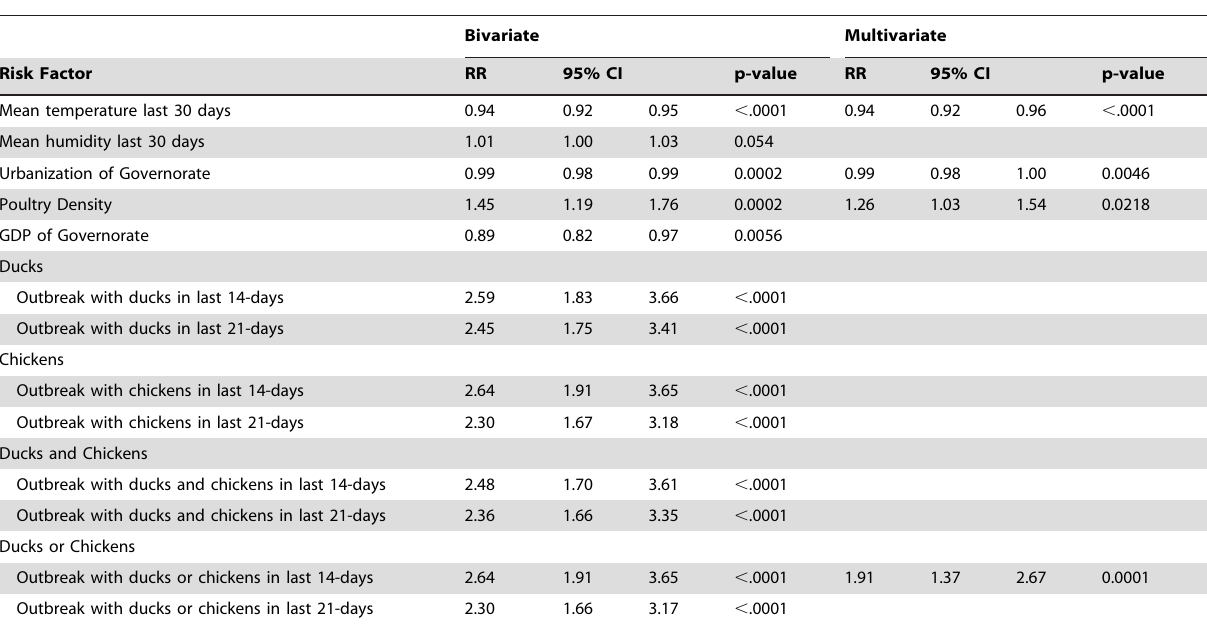
Table 2. Predictors of human H5N1 case occurrence in a governorate.